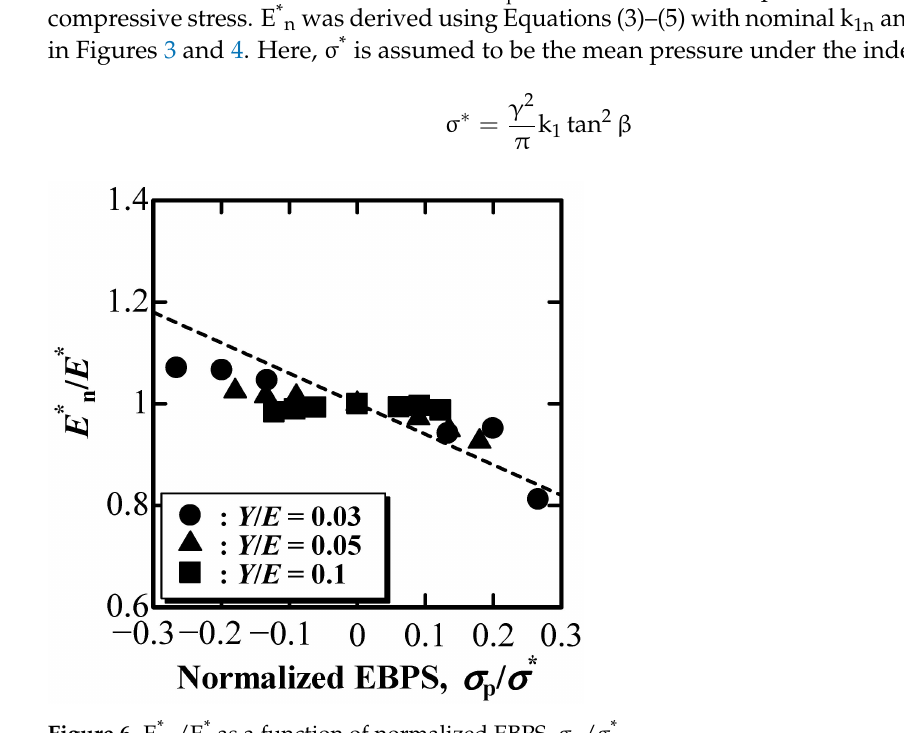
Figure 6. E * n /E * as a function of normalized EBPS, σ p / σ *